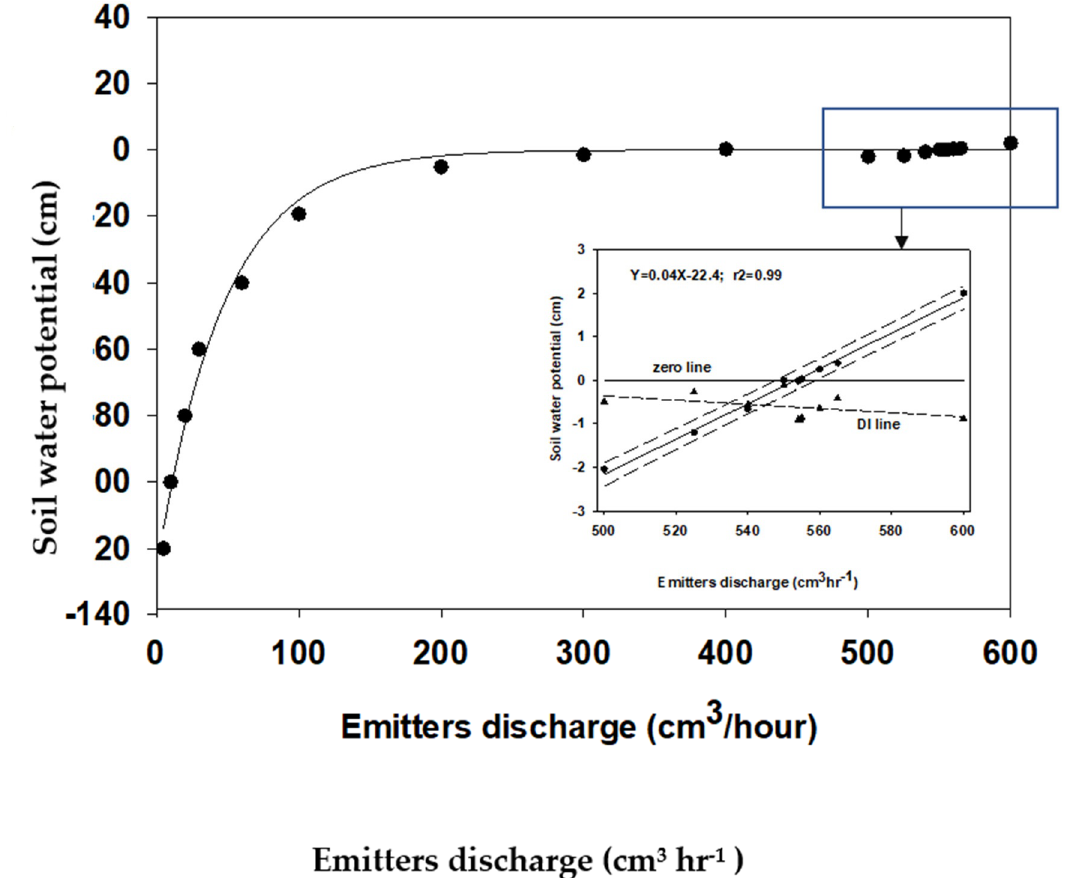
Figure 6. General view of soil water potential near the orifice as a function of emitter discharge. The internal figure is an amplification of the calculated soil water potential when the emitter discharge is increased from 500 to 600 cm 3 around zero. In this amplification, the solid horizontal line marks the point of zero water potential. The long dash band marks the 95% confidential band and the points within the band are simulated numerically. Their regression line is the soil water potential at the outlet of water from the orifice ( ψ soil = 0.04 × q − 22.4; r 2 = 0.99). The triangles connect the simulated DI potentials at the same emitter discharge.